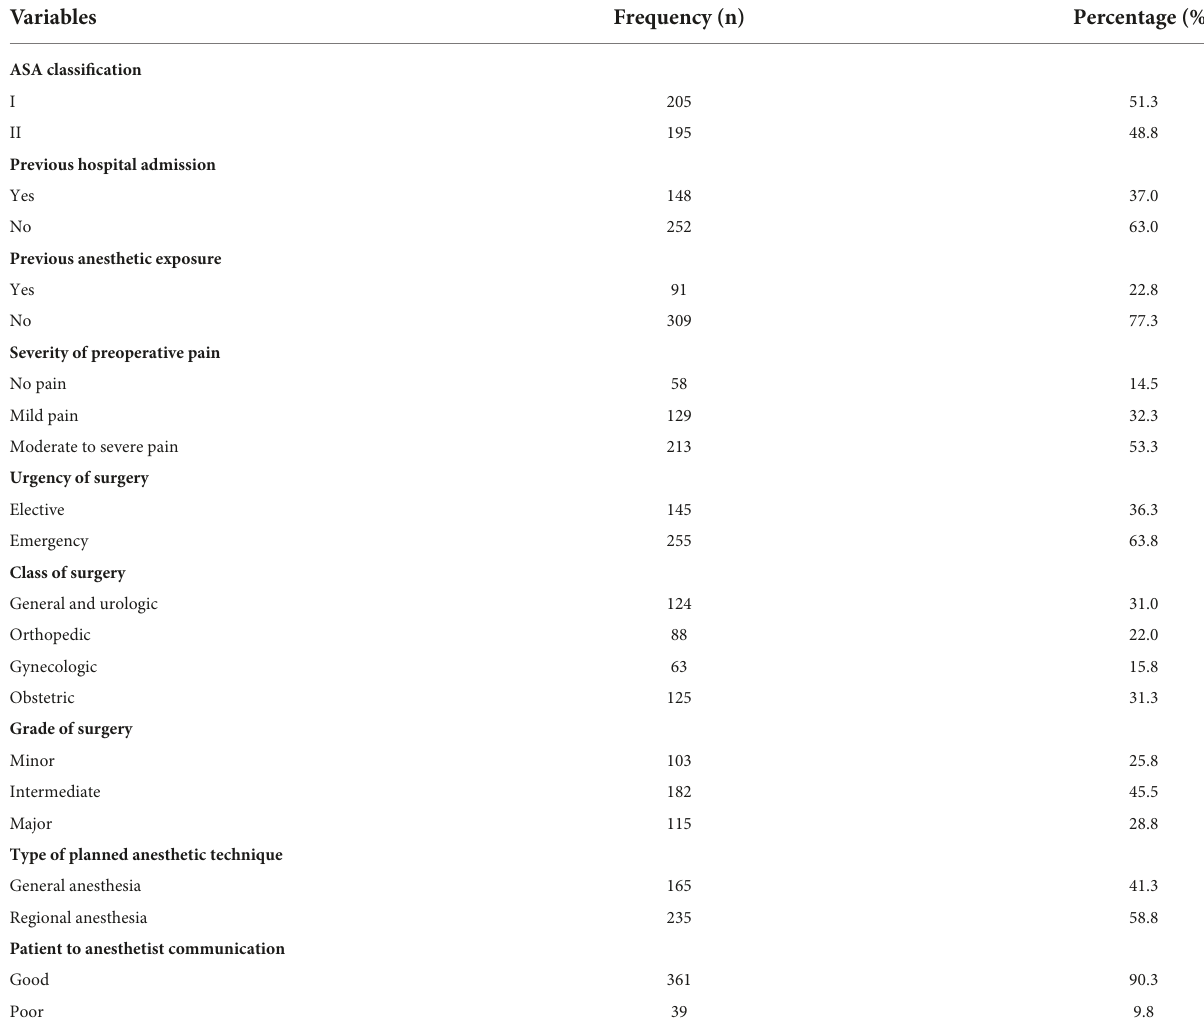
TABLE 2 Health status and clinical characteristics of surgical patients, N =